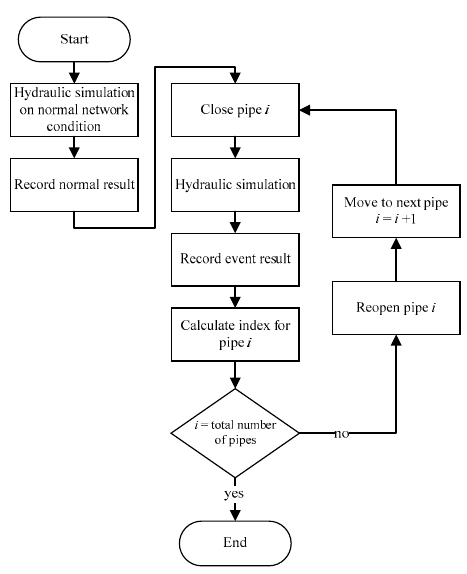
Figure 1. Flowchart of the calculation steps.